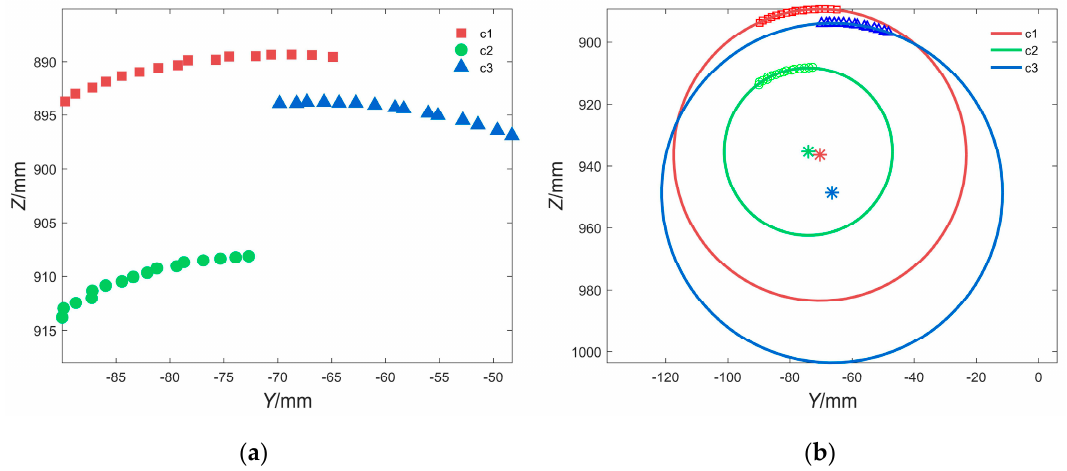
Figure 10. ( a ) Projection of the optical centers on the Y w O w Z w plane; ( b ) fitted circular curve (red*, green* and blue* are the fitted centers of the three fitted curves marked by c 1 , c 2 and c 3 , respectively). Three sets of the optical centers and the fitted circular arcs with different radii on the O w - Y w Z w plane are shown in Figure 11a,b. Employing the optical center coordinates, the distance among c 1 , c 2 and c 3 are calculated, c 1 c 2 = 20.16 mm and c 1 c 3 = 20.08 mm. The errors of the distance are 0.78% and 0.42%, respectively. The fitting results and the root mean square error (RMSE) of the three groups are displayed in Table 3. The average value of the three fitted centers is O r = (-55.20, 961.67) mm,